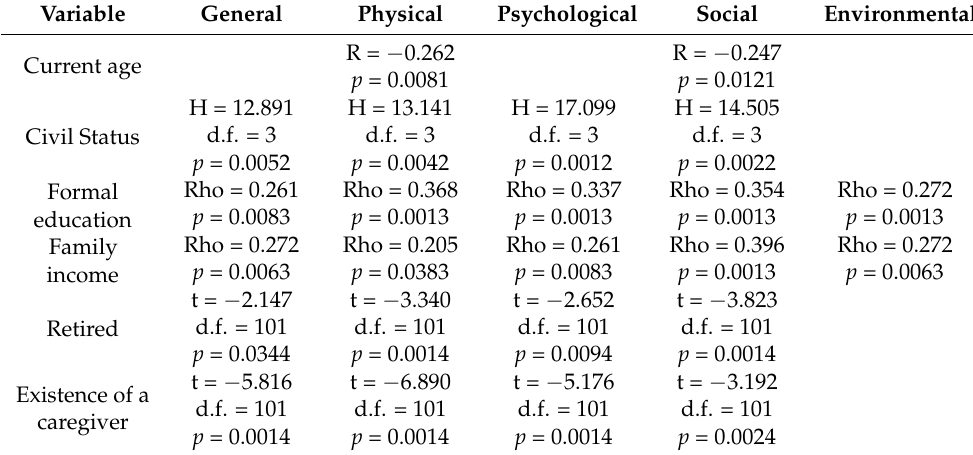
Table 3. Association between HRQoL domains and sociodemographic variables ( n =